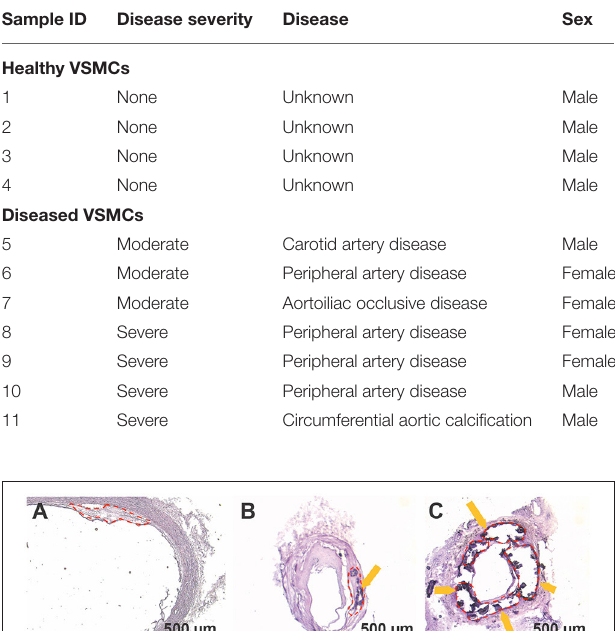
TABLE 1 | VSMCs isolated from vessels classified by disease severity based on the extent of calcification and plaque area.